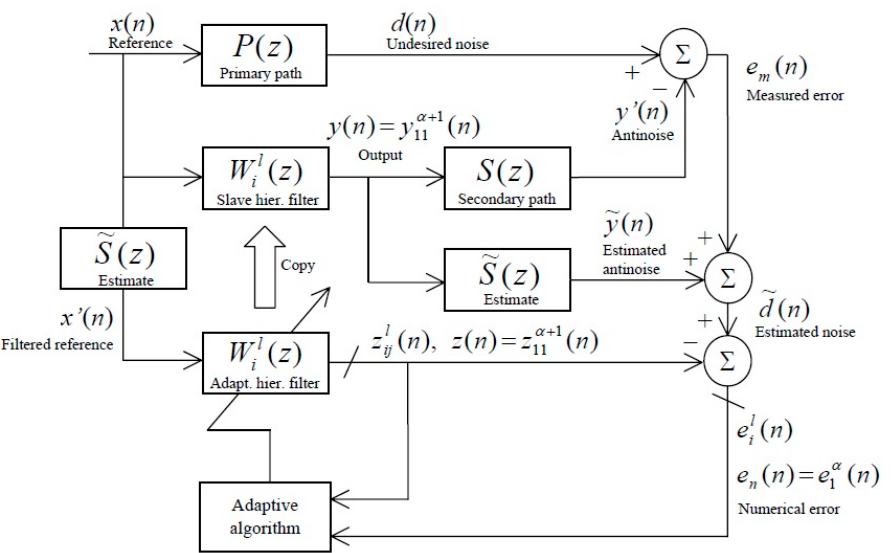
Figure 2. Block diagram of the modified filtered-x hierarchical LMS algorithm with sequential partial updates.